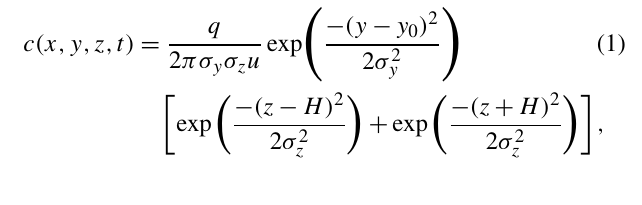
values for the over-city path (blue triangles) and reference path (red 2 . The 4